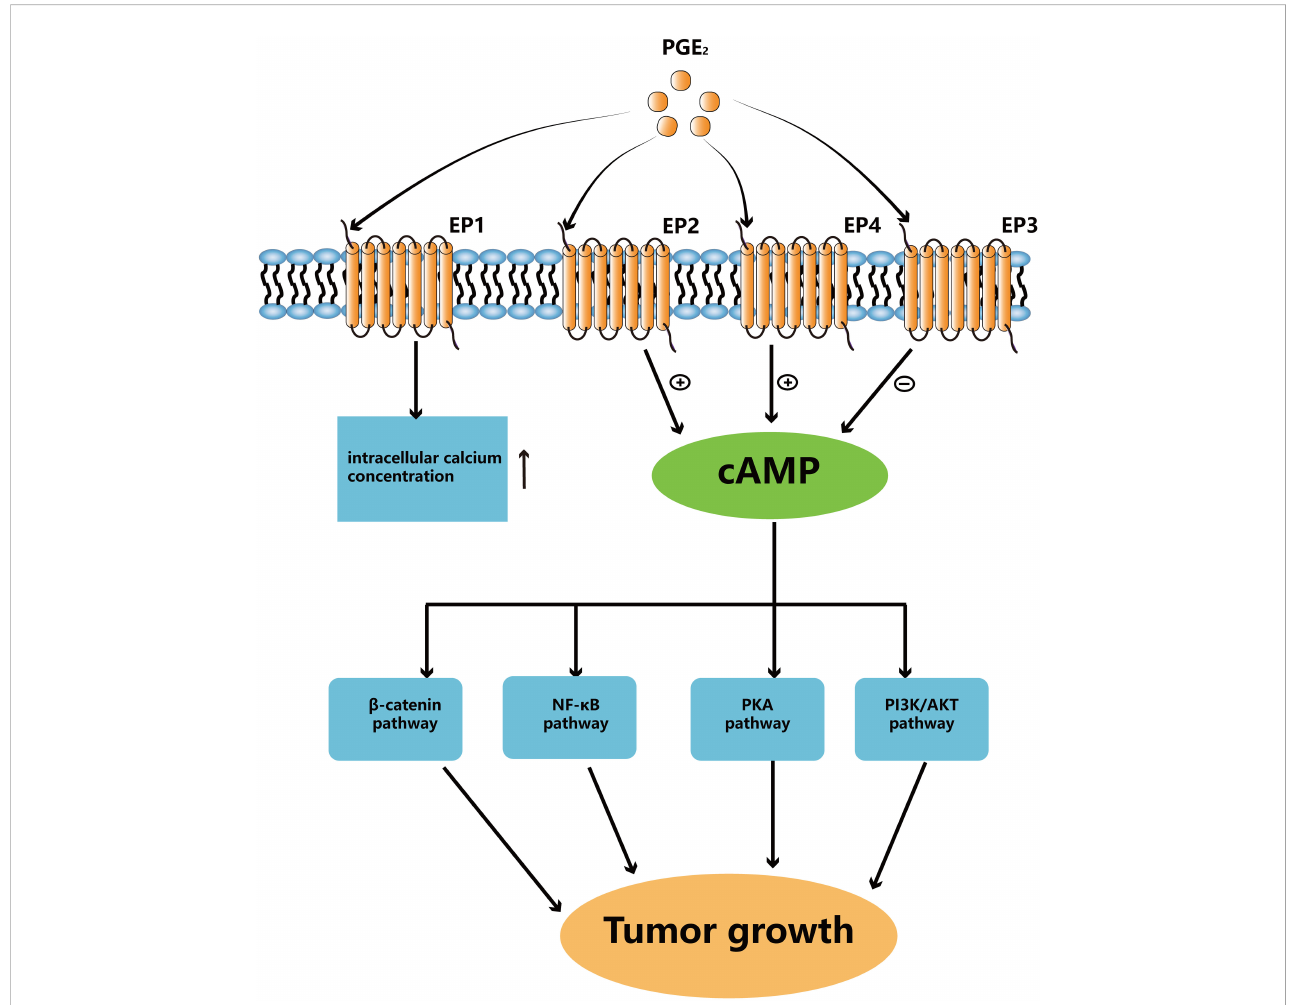
FIGURE 2 PGE 2 binds to different EPs to activate downstream signaling pathways. Activated EP1 can upregulate the level of intracellular calcium ion concentrations. EP2 and EP4 can upregulate cAMP levels to activate different pathways which can promote tumor growth. EP3 is responsible for downregulating cAMP